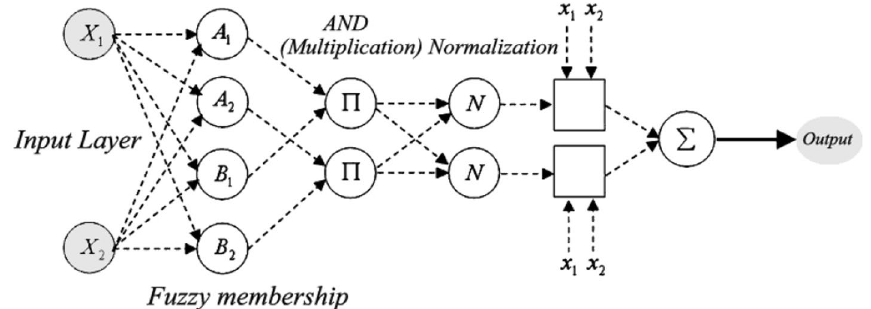
Fig. 2 A view of the CANFIS